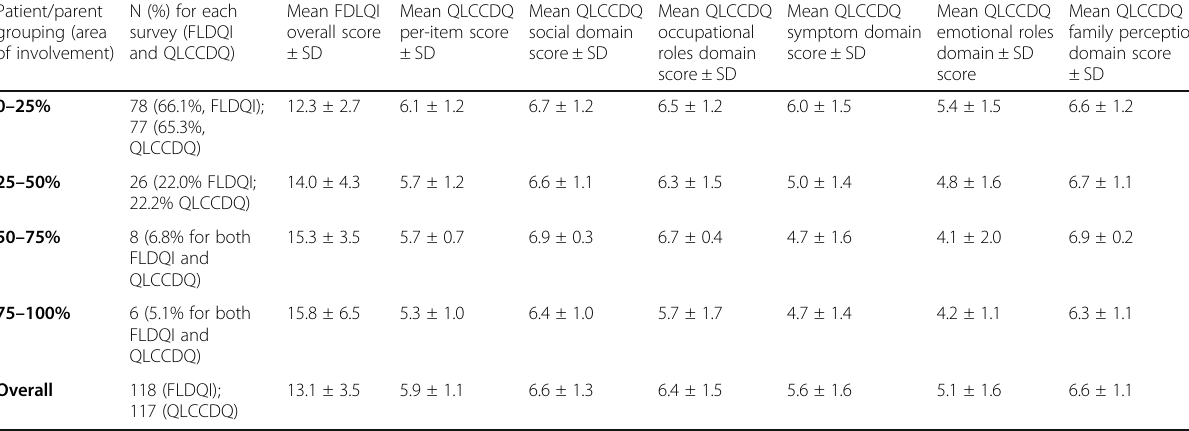
Table 2 Summary of QoL survey results by % of area of involvement in vitiligo participants Patient/parent grouping